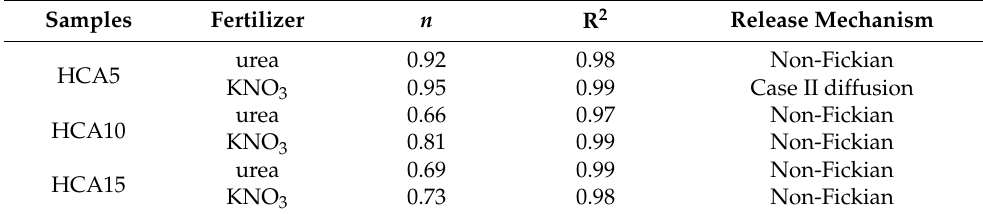
Table 2. Release exponent ( n ), correlation coefficient (R 2 ) and diffusion mechanism at different hydrogel